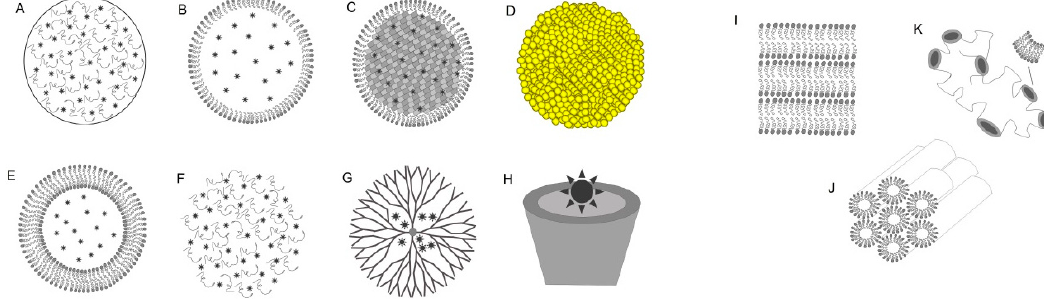
Figure 2. Schematic representation of nanotechnology-based drug delivery systems such as ( A ) polymeric nanoparticles (PNPs); ( B ) nanostructured lipid carriers (NLCs); ( C ) solid lipid nanoparticles (SLNs); ( D ) gold nanoparticles (AuNPs); ( E ) liposomes; ( F ) hydrogels; ( G ) dendrimers; ( H ) cyclodextrin; and ( I ) lamellar; ( J ) hexagonal; or ( K ) cubic mesophases liquid crystallines for photodynamic therapy of cancer.